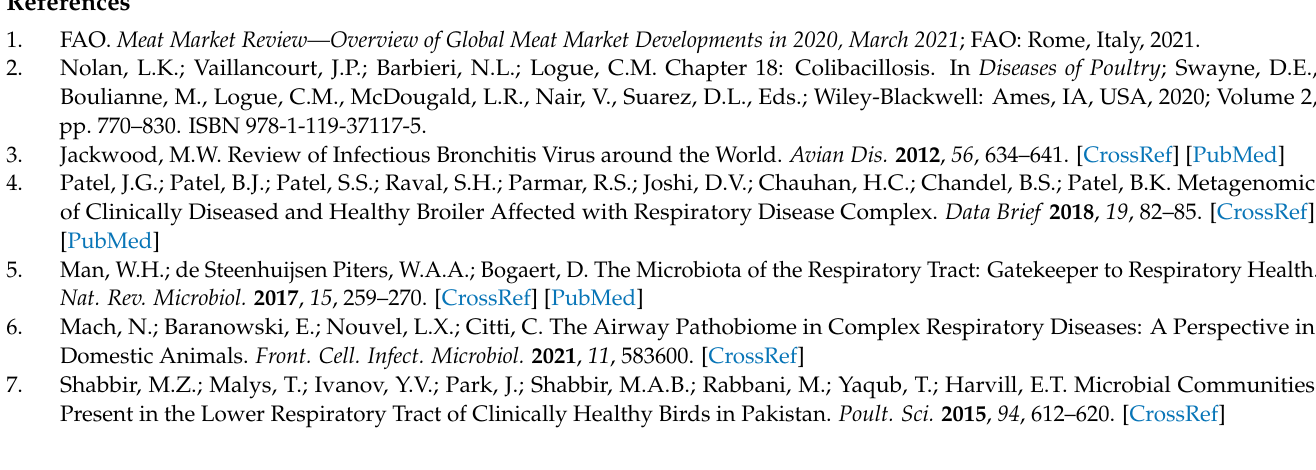
List of OPUs and their closest relative sequence; Figure S3: Dendrogram analysis of tracheal samples; Figure S4: Beta-diversity analysis of environmental air and tracheal samples; Figure S5: Sampling of 1000 L of air in PCA plates with filter paper. Figure S6: DNA electrophoresis of tracheal